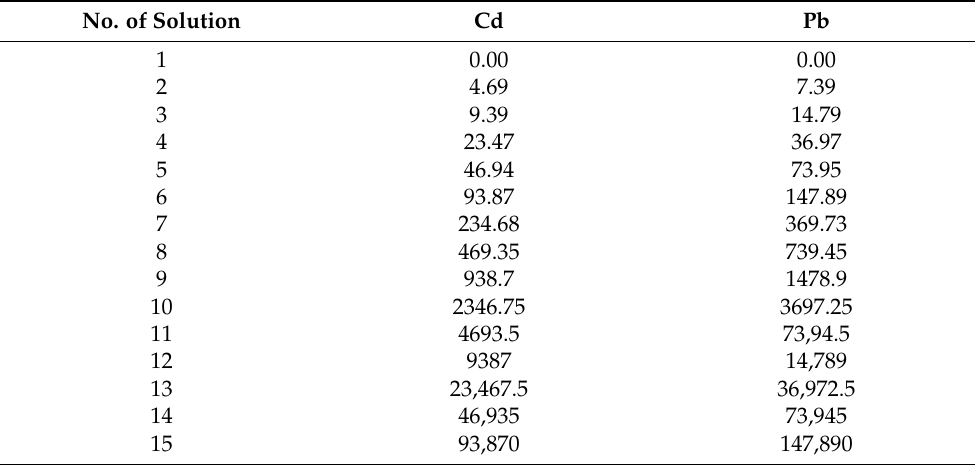
Table 1. The concentrations of Cd and Pb of the 15 gradient solutions (unit: µ g/L).